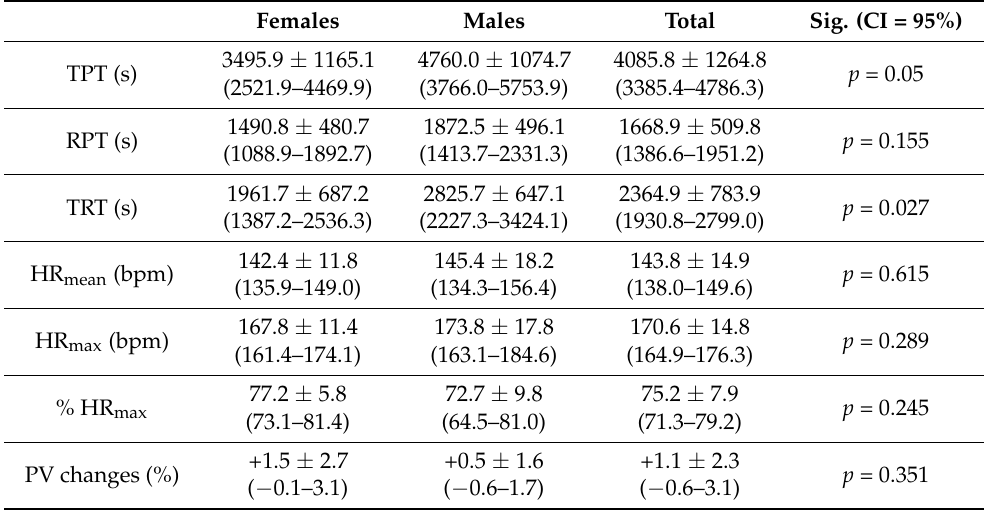
Table 2. Characteristics of simulated padel